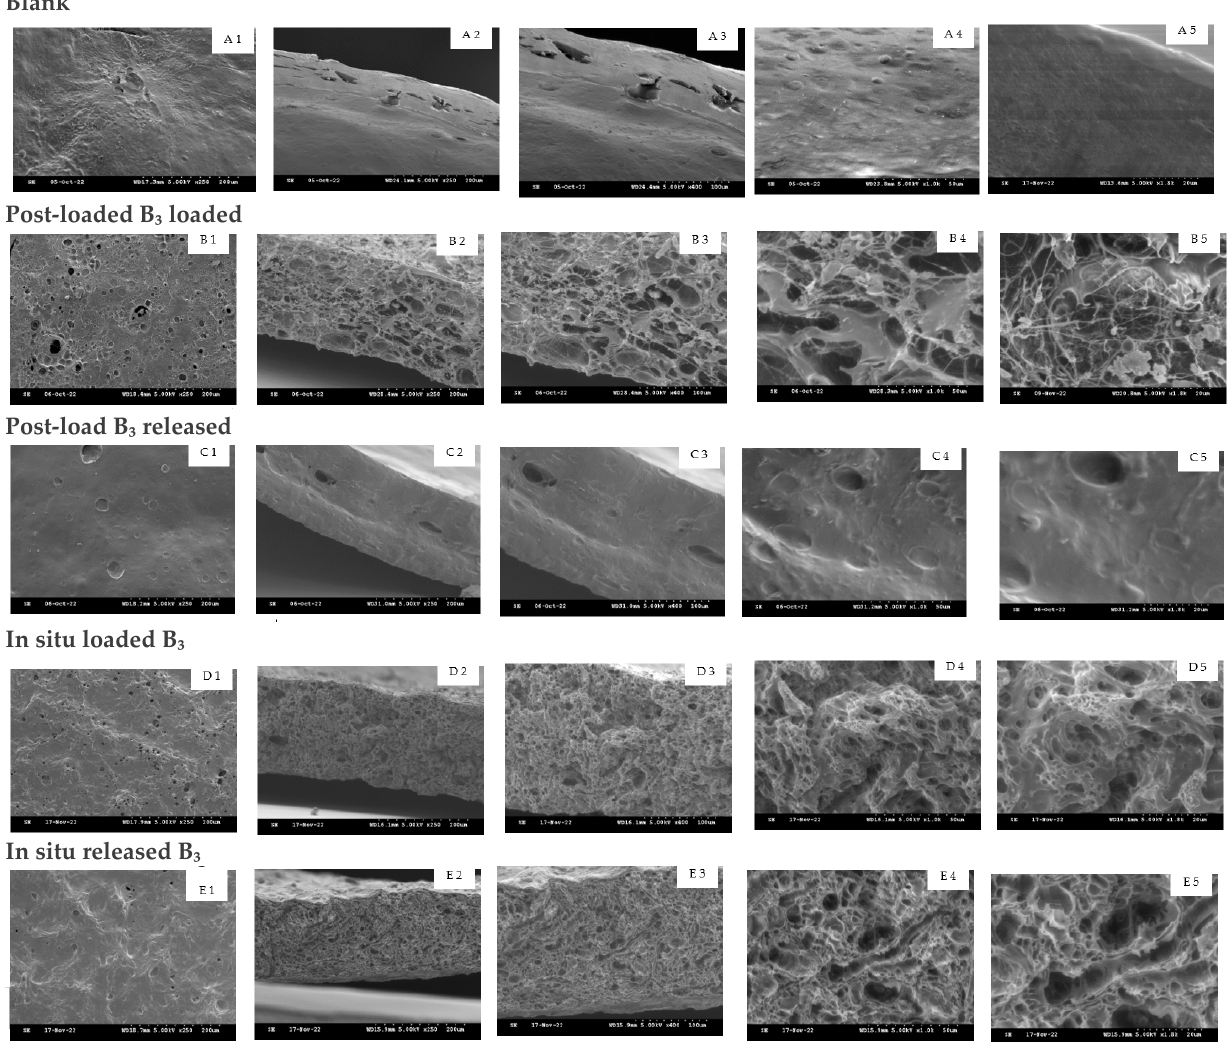
Figure 5. SEM images of the freeze-dried HA hydrogel films comparison. ( A1 – A5 ) blank (unmedi- cated) hydrogel film. ( B1 – B5 ) B ₃ post-loaded hydrogel film. ( C1 – C5 ) B ₃ post-loaded hydrogel film after release. ( D1 – D5 )B ₃ in situ loaded hydrogel film. ( E1 – E5 ) B ₃ in situ loaded hydrogel film after